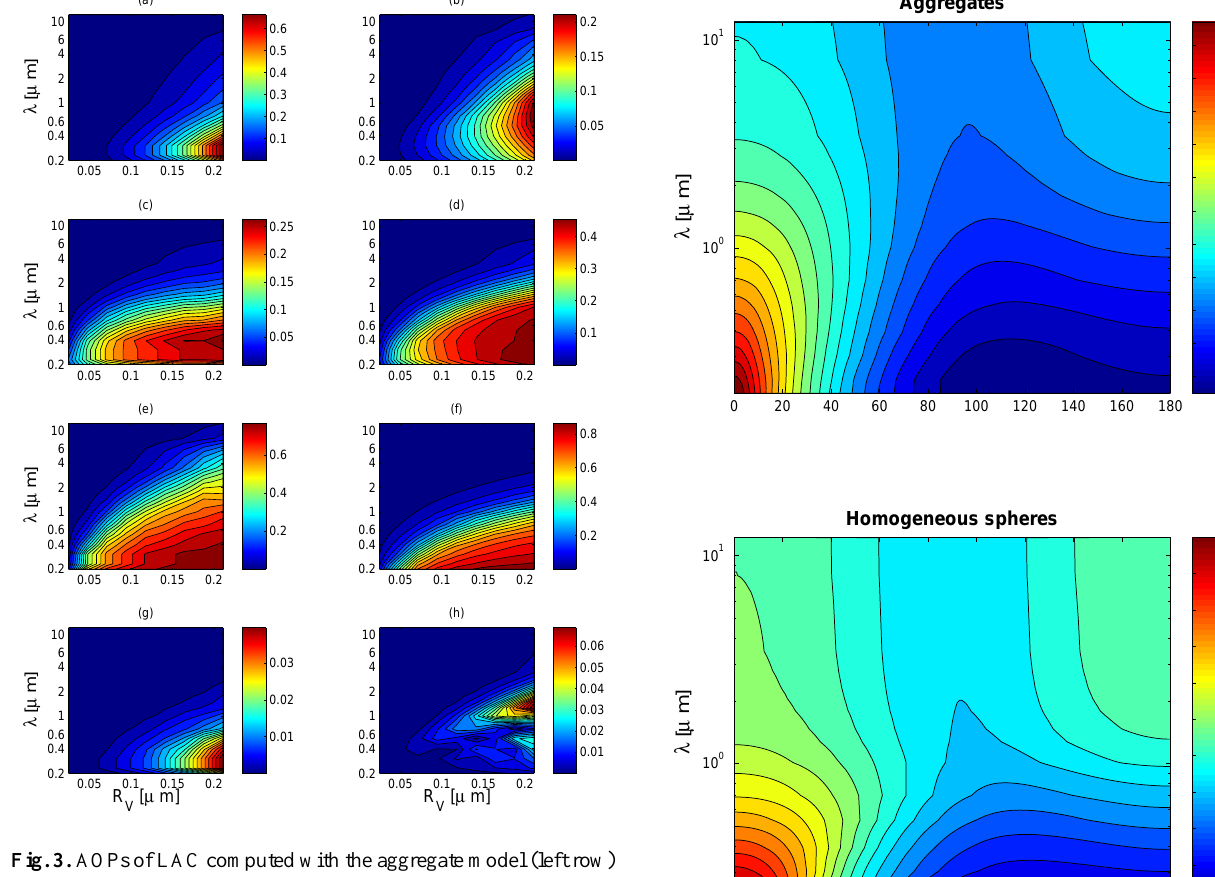
Fig. 3. AOPs of LAC computed with the aggregate model (left row) and with the HSA (right row) as a function of volume-equivalent radius R V and wavelength λ . The panels show C abs (first row), ω (second row), g (third row), and C bak (fourth row).